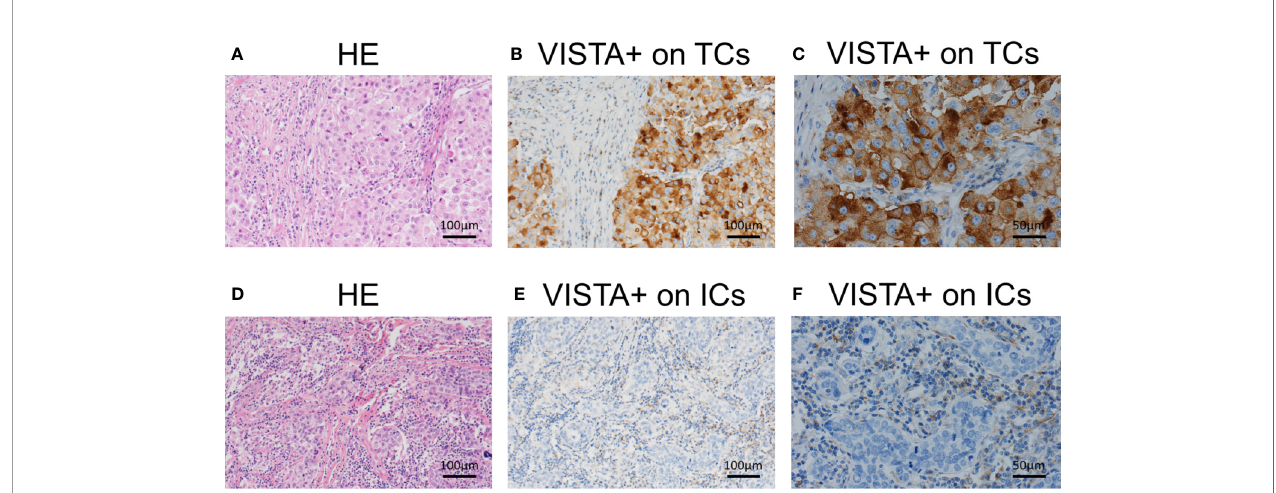
FIGURE 1 | Representative immunohistochemical staining of V-domain Ig suppressor of T-cell activation (VISTA) on tumor cells and immune cells in triple-negative breast cancer. (A) Hematoxylin and eosin (HE) staining of the tumor microenvironment. (B) VISTA expression on tumor cells (Original magni fi cations×100). (C)